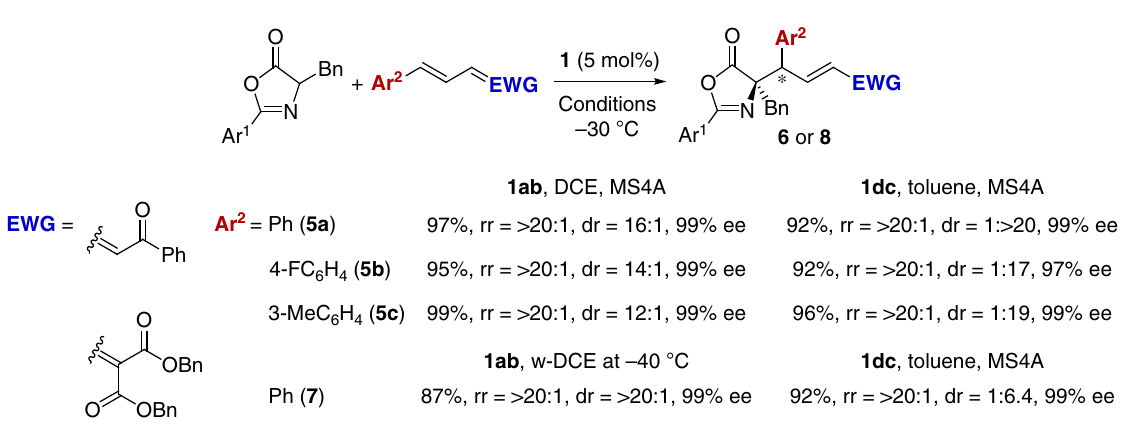
NATURE COMMUNICATIONS|8:14793|DOI: